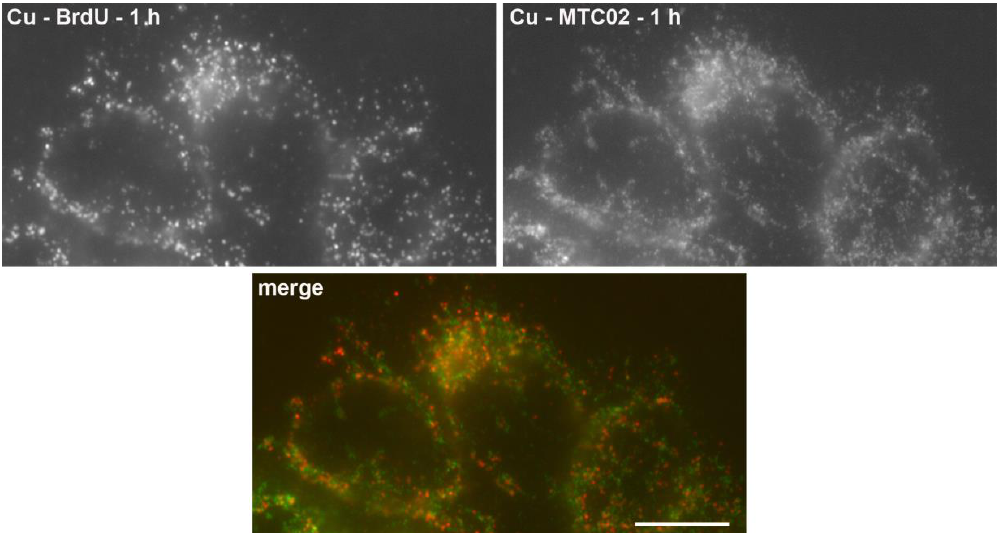
Figure 4. The detection of the BrdU-labeled DNA in mitochondria. The detection of the BrdU-labeled DNA (red in the color image) after a 1-hour BrdU pulse in cells treated with 4 mM copper(I) for 60 s followed by exonuclease III cleavage is shown. A simultaneous co-localization with the mitochondrial marker MTC02 has been performed (green in the color image). Bar: 10 µ m. Adapted with permission from Ligasov á et al., 2012, Atomic Scissors: a new method of tracking the 5-bromo-2 (cid:48) -deoxyuridine-labeled DNA in situ. PLoS ONE 7(12): e52584